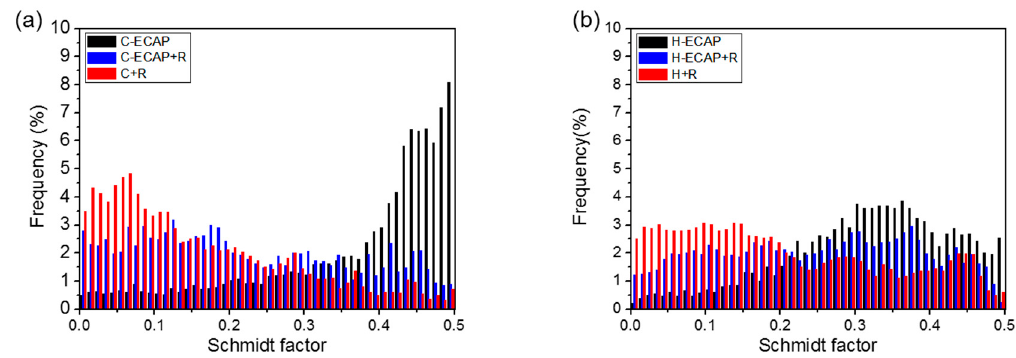
Figure 9. Schmidt factor statistics of ( a ) C-ECAP, C-ECAP + R and C + R alloys; ( b ) H-ECAP, H-ECAP + R and H + R alloys.